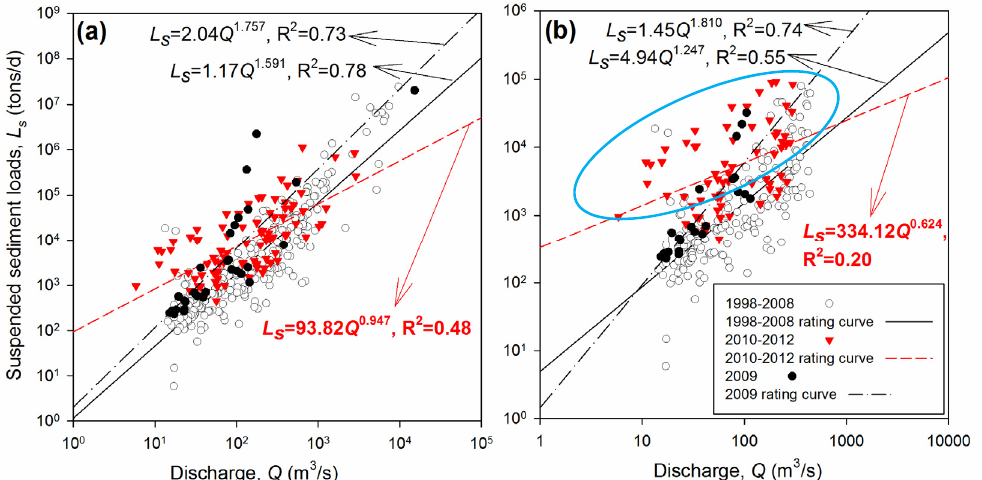
Figure 9. Suspended sediment load and flow discharge ( L s - Q ) rating curves developed based on measurements in Liling Bridge, Gaoping River, during the pre-Morakot (1998–2008), Morakot (2009), and post-Morakot (2010–2012) periods. Rating curves developed based on ( a ) all data; and ( b ) 75% low to medium flow data. Anomaly values are during dry and low-flow conditions (circled